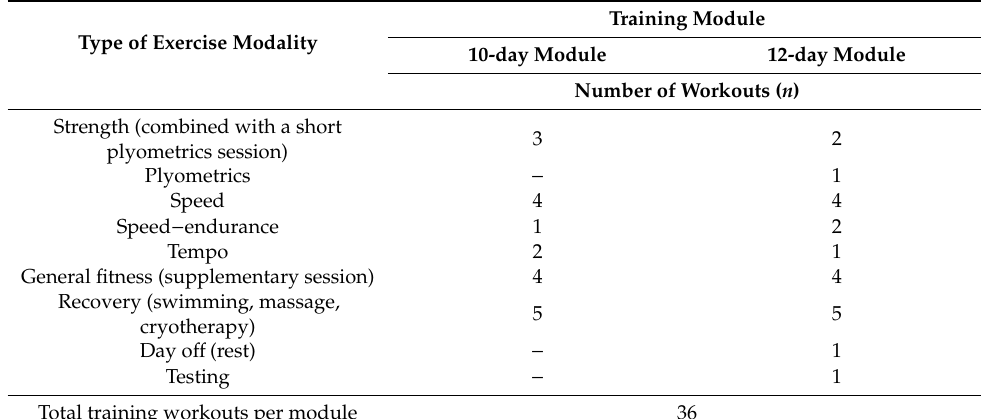
Table 1. Training characteristics of the training